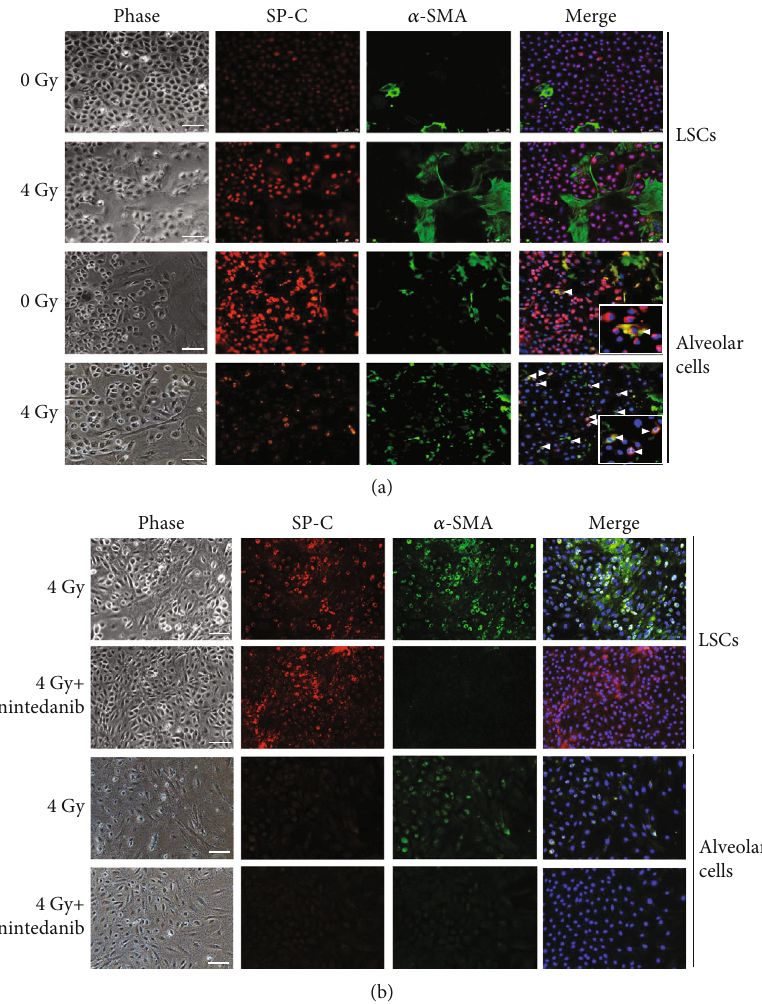
Figure 5: Nintedanib attenuates radiation-induced pulmonary cell fi brogenic di ff erentiation. (a, b) LSCs and LSC-di ff erentiated alveolar cells were exposed to 4Gy followed by treatment with or without nintedanib (1 μ M) and then incubated for 3 days. The levels of SP-C (red) and α - SMA (green) protein were determined by coimmunostaining. The arrowheads indicate SP-C + / α -SMA + cells. The nuclei of cells were stained blue with DAPI. Scale bars, 75 μ